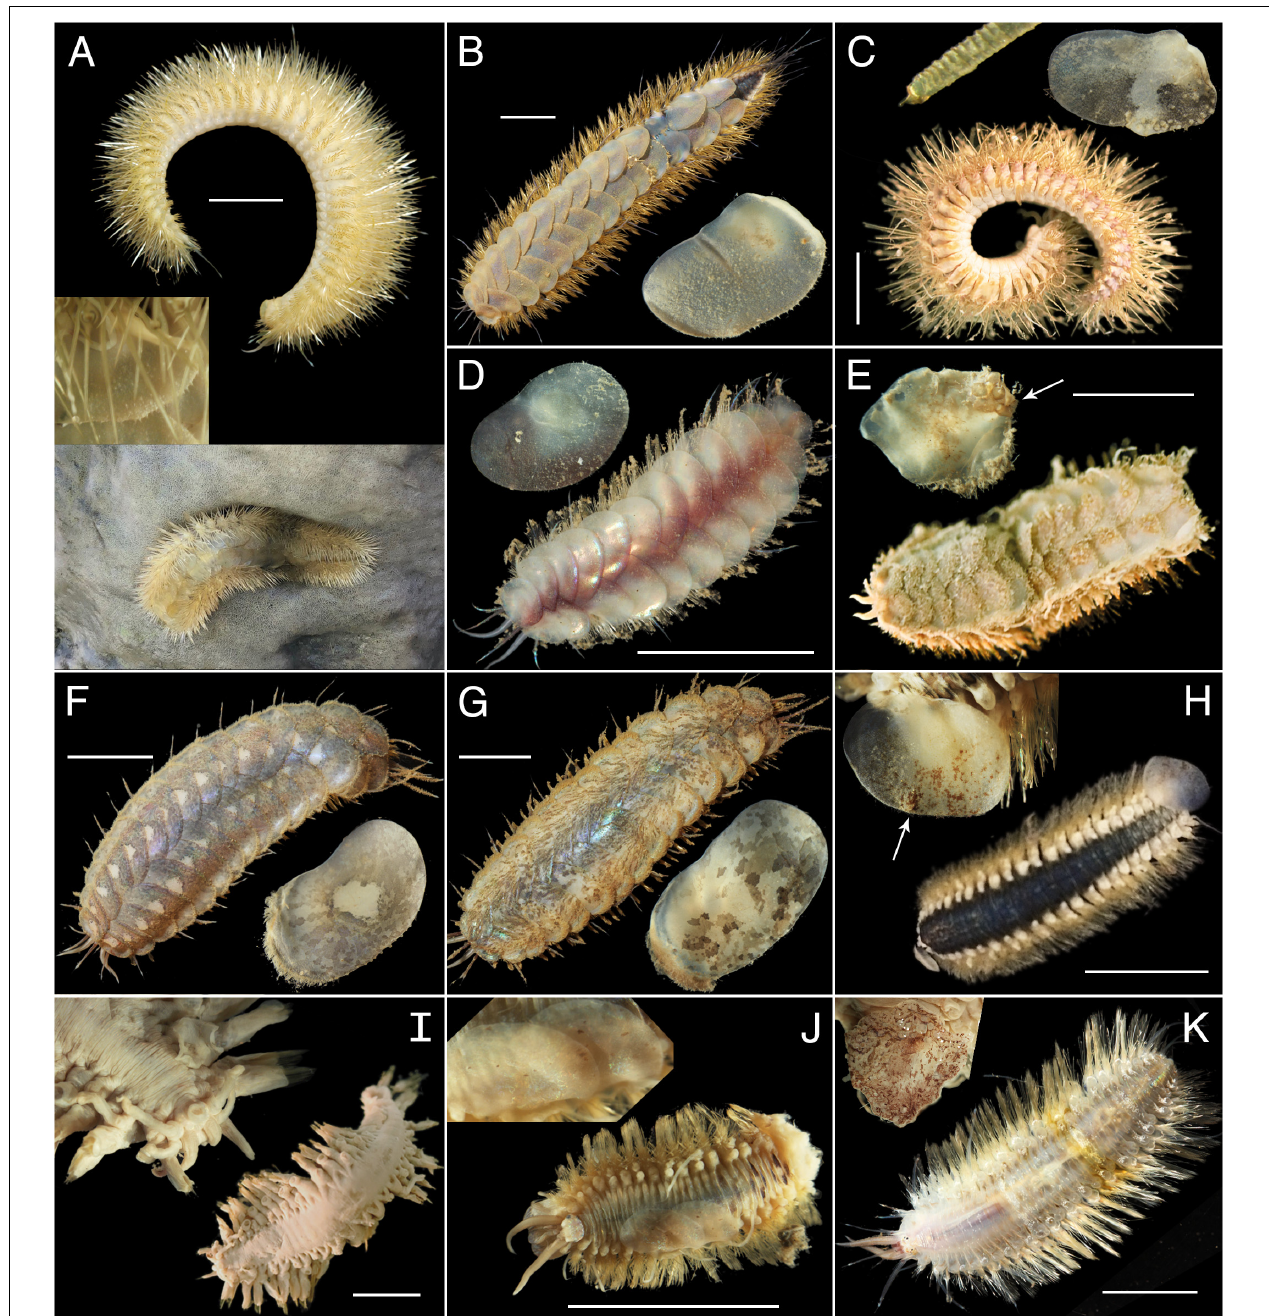
FIGURE 4 | Specimen imagery highlighting morphospecies diversity of the family Polynoidae collected JR17003a expedition. See also Figure 3I . (A) Antarctinoe ferox live image, lateral view (top), detail of elytra on preserved specimen (middle) and live, in situ image of specimen sitting in glass sponge; (B) Antarctinoe cf. ferox NHM_232, live image, with detail of midbody elytron (preserved); (C) Antarctinoe spicoides , preserved specimen, lateral view (bottom), detail of long notochaetal spine with pin tip (top left) and detail of midbody elytron (right); (D) Austrolaenilla antarctica live image, with detail of midbody elytron (preserved); (E) Barrukia cristata , preserved specimen, with detail of elytron with arrow highlighting large macrotubercles; F Harmothoe cf. fuligineum NHM_233, live image, with detail of elytron (preserved); (G) Harmothoe fuligineum , with detail of elytron; (H) Harmothoe cf. fullo NHM_330, preserved specimen, with detail of elytron, arrow highlighting mound on posterior margin; (I) Macellicephalinae sp. NHM_234L, preserved specimen, with detail of anterior (top left); (J) Polynoidae sp. NHM_140, preserved specimen, with detail of elytra; (K) Polynoidae sp. NHM_228, live image, with detail of elytron (preserved specimen, different individual to one shown in live image). All scale bars = 1